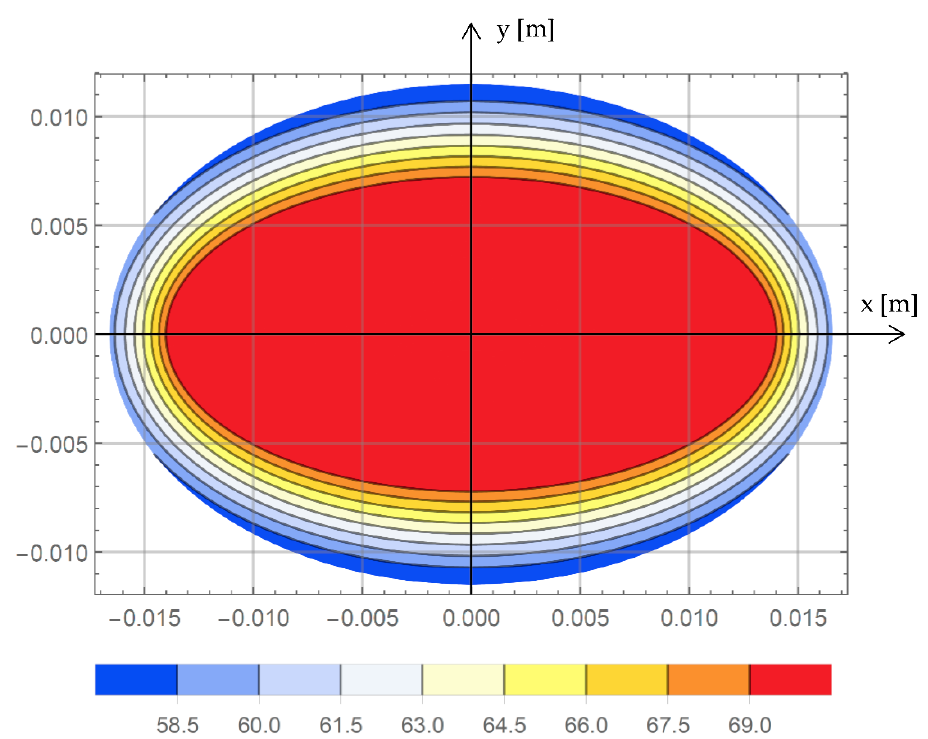
Figure 4. Thermal field distribution in the cross-section of the elliptical conductor under current load I cr = 574.5